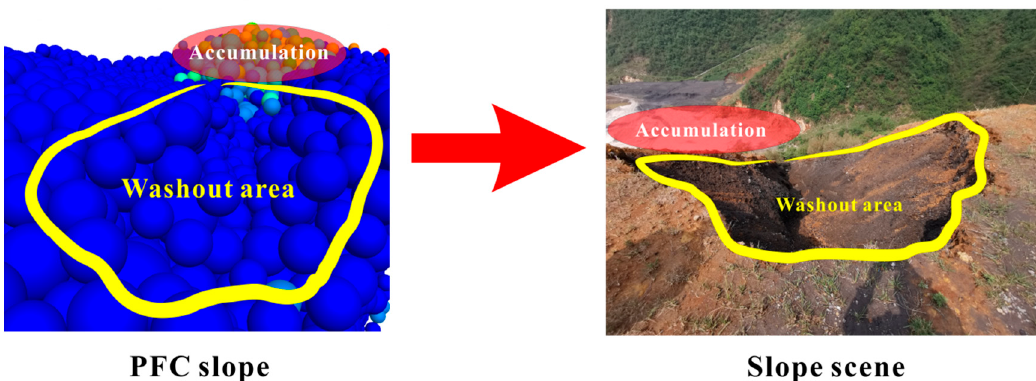
Figure 10. Comparison between modelled No. 3 gully and its field appearance.